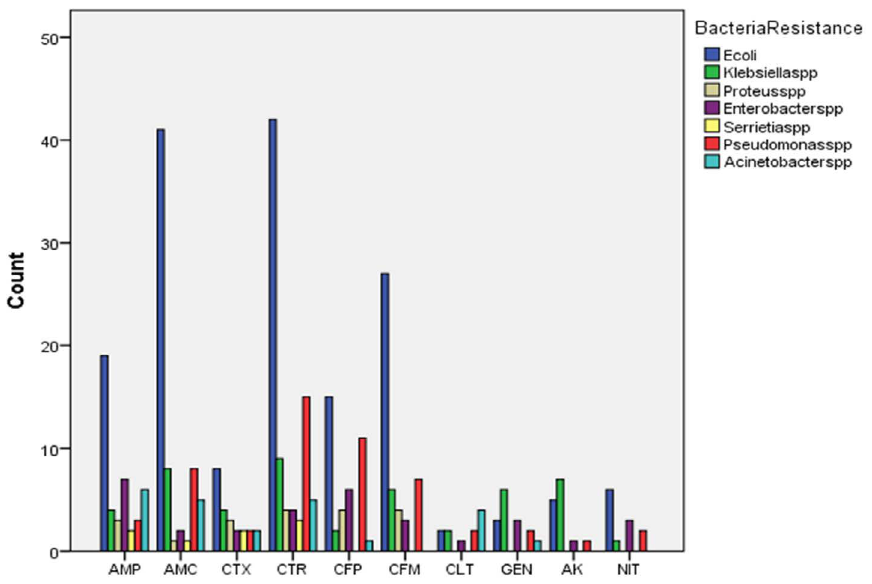
Fig. 2. Antibiotic Resistance in Gram Negative